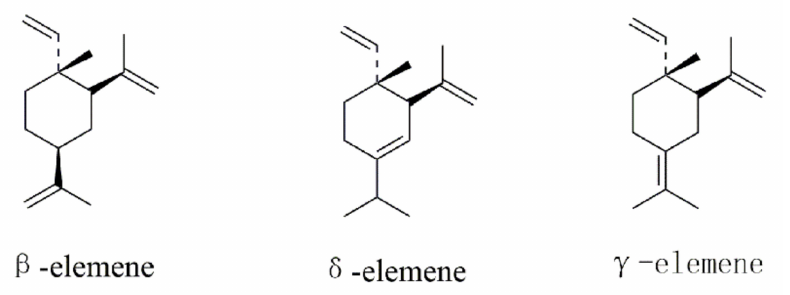
Figure 2. The structural formula of